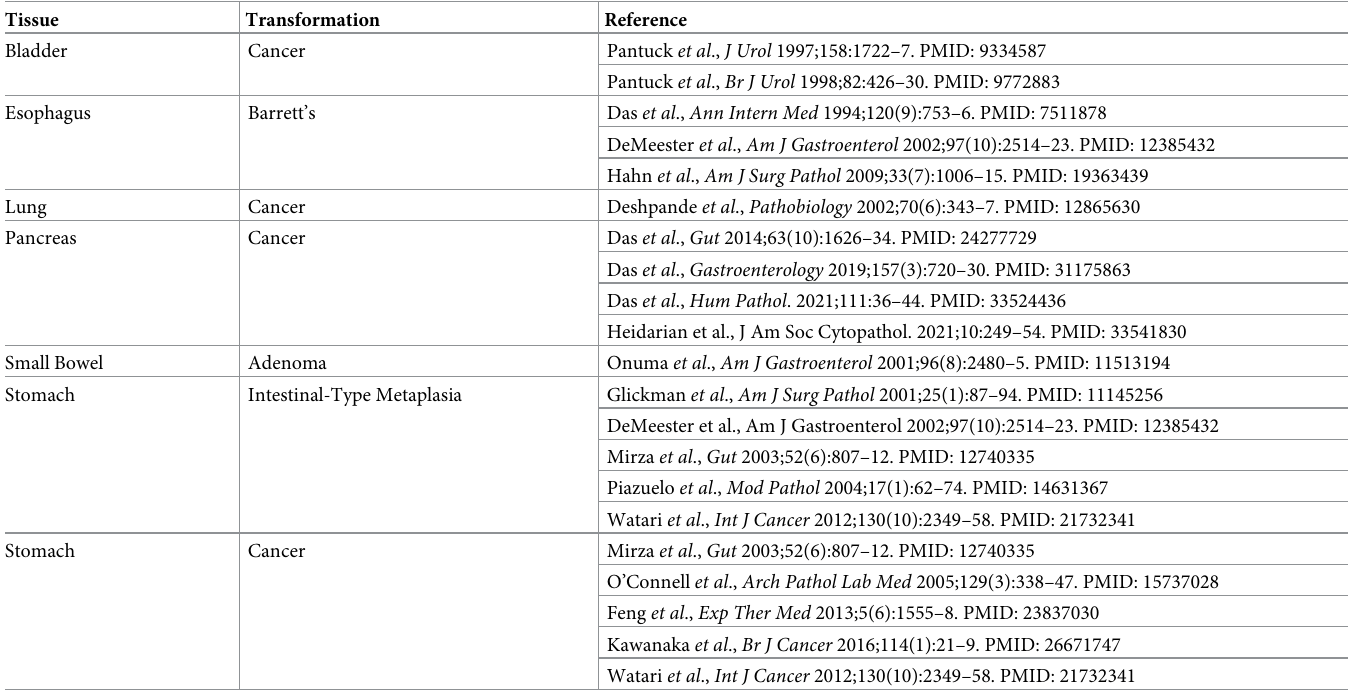
Table 1. Summary of the prior literature describing Das-1 reactivity after metaplasic and/or oncogenic transformation of adult tissues that do not natively express this antigen at